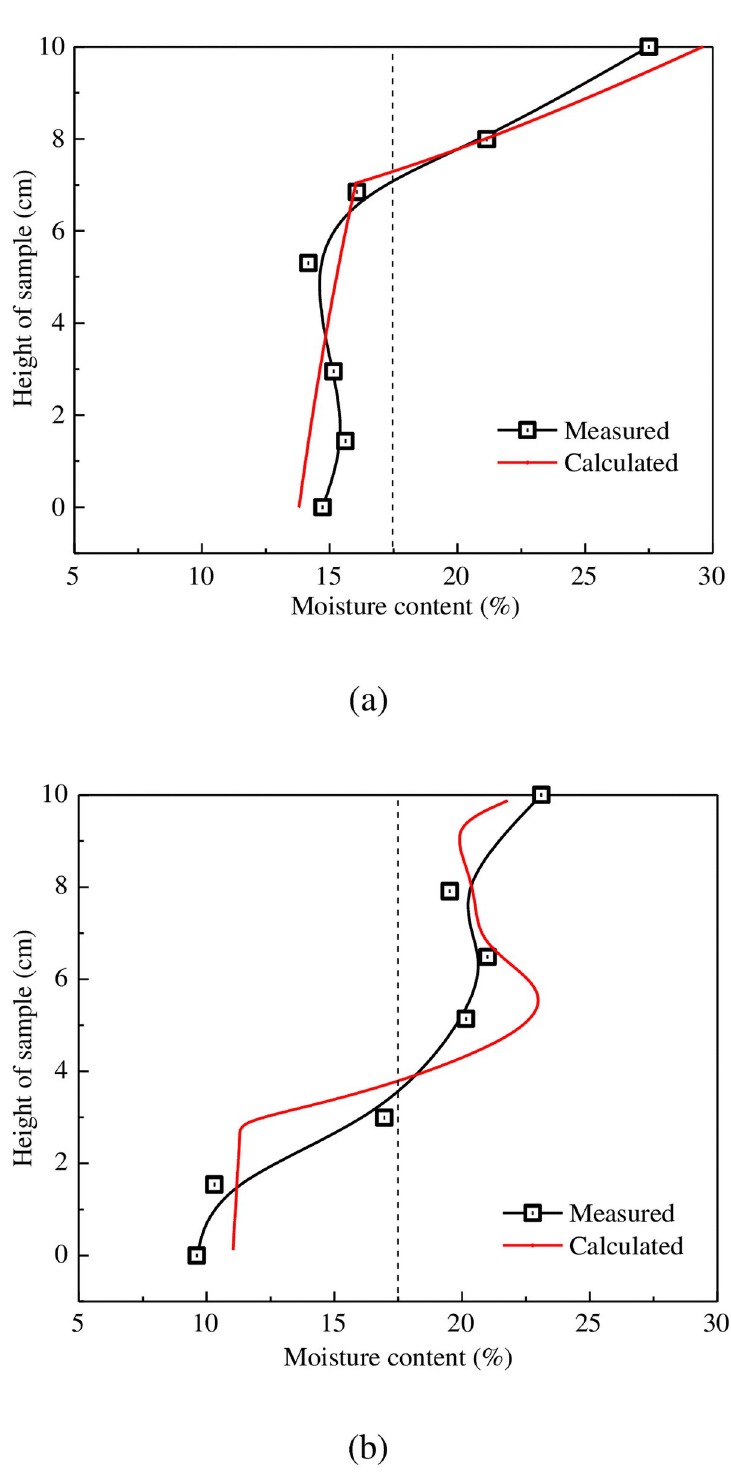
Fig 5. Distribution characteristics of soil moisture content after each freezing test for a soil-surface temperature of (a) − 0.75˚C and (b) − 3˚C.